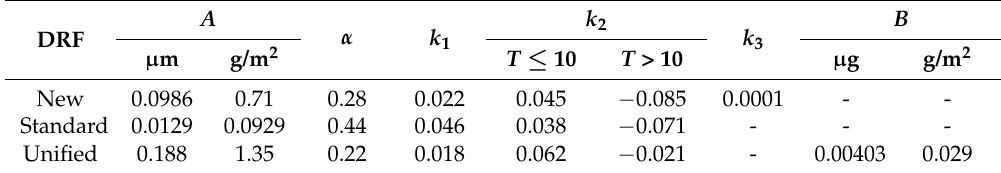
Table 8. Values of coefficients used in the nonlinear DRFs for